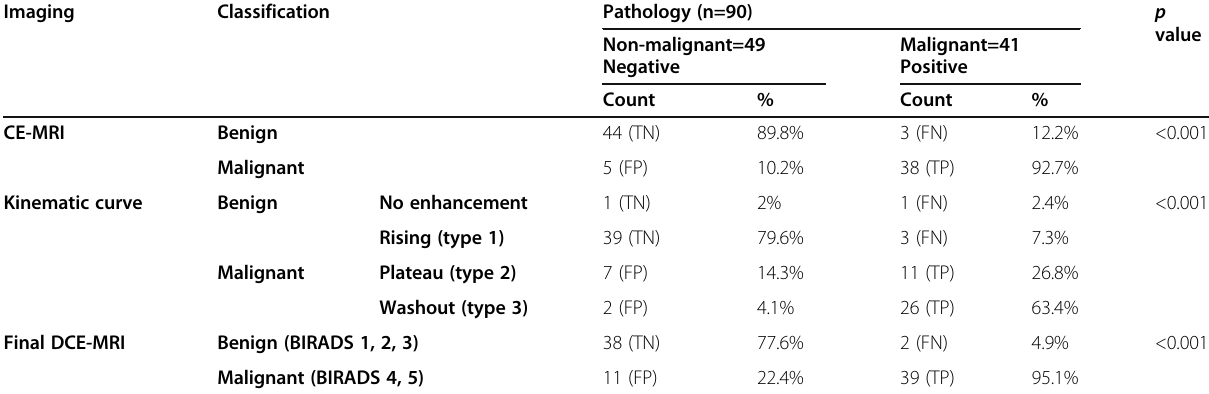
Table 3 DCE-MRI (CE-MRI, kinetic analysis, and combined) classification of lesions in correlation with final pathology